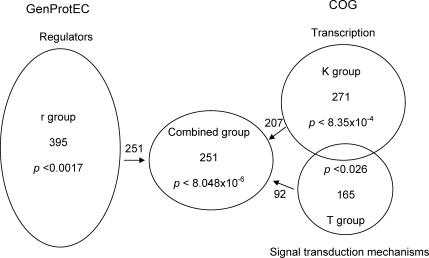
Gene Sets Functioning in Transcriptions Assigned by GenProtEC and COGThe sizes of each set are indicated. The construction of the combined set is shown. (We note that the COG categories are not disjoint, so the same protein can appear in more than one COG group.) The statistical significances of the association of each set with SIDD0 sites are also given.